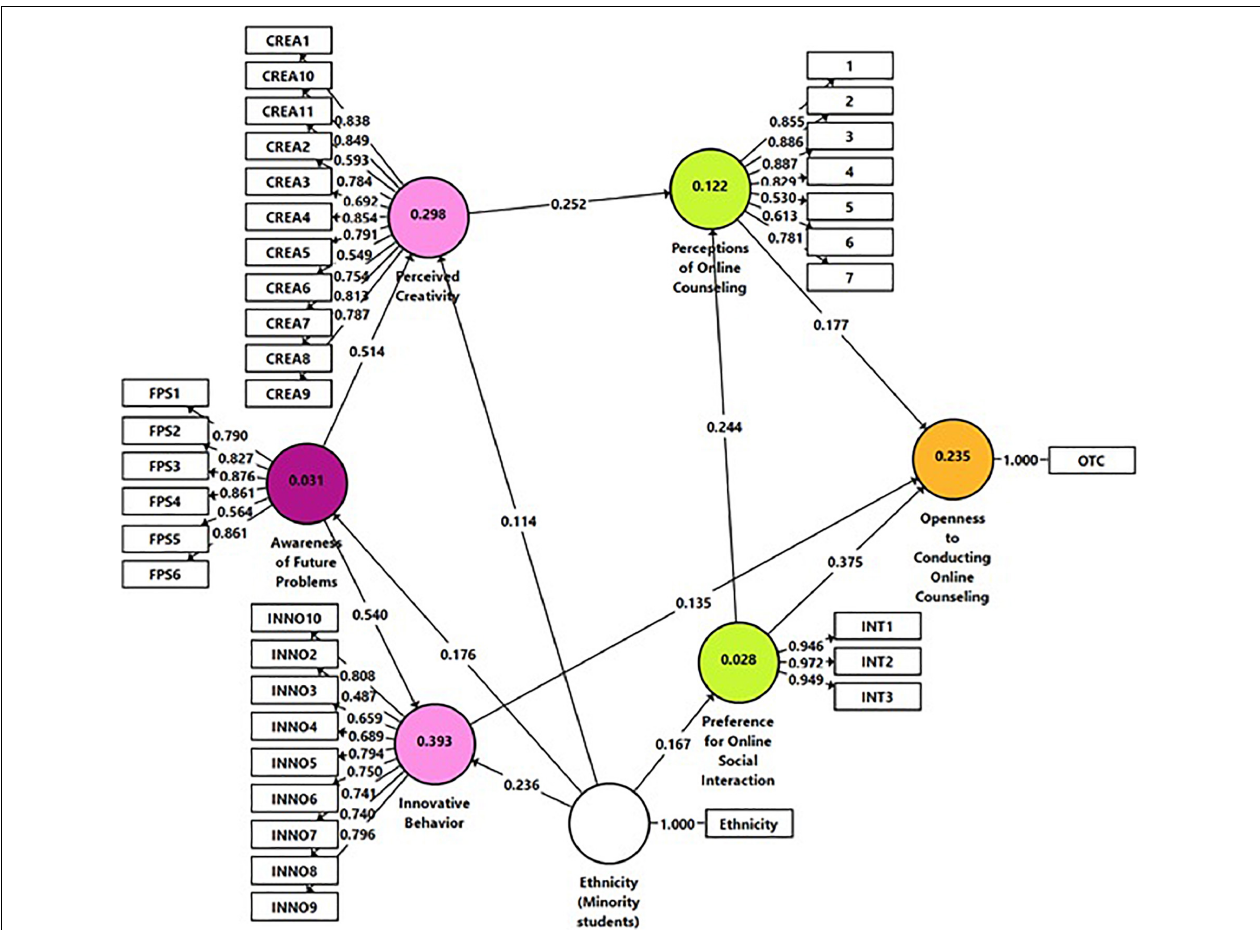
FIGURE 2 | Model 2. Analysis results of the examination of H1-H5 by smartPLS.